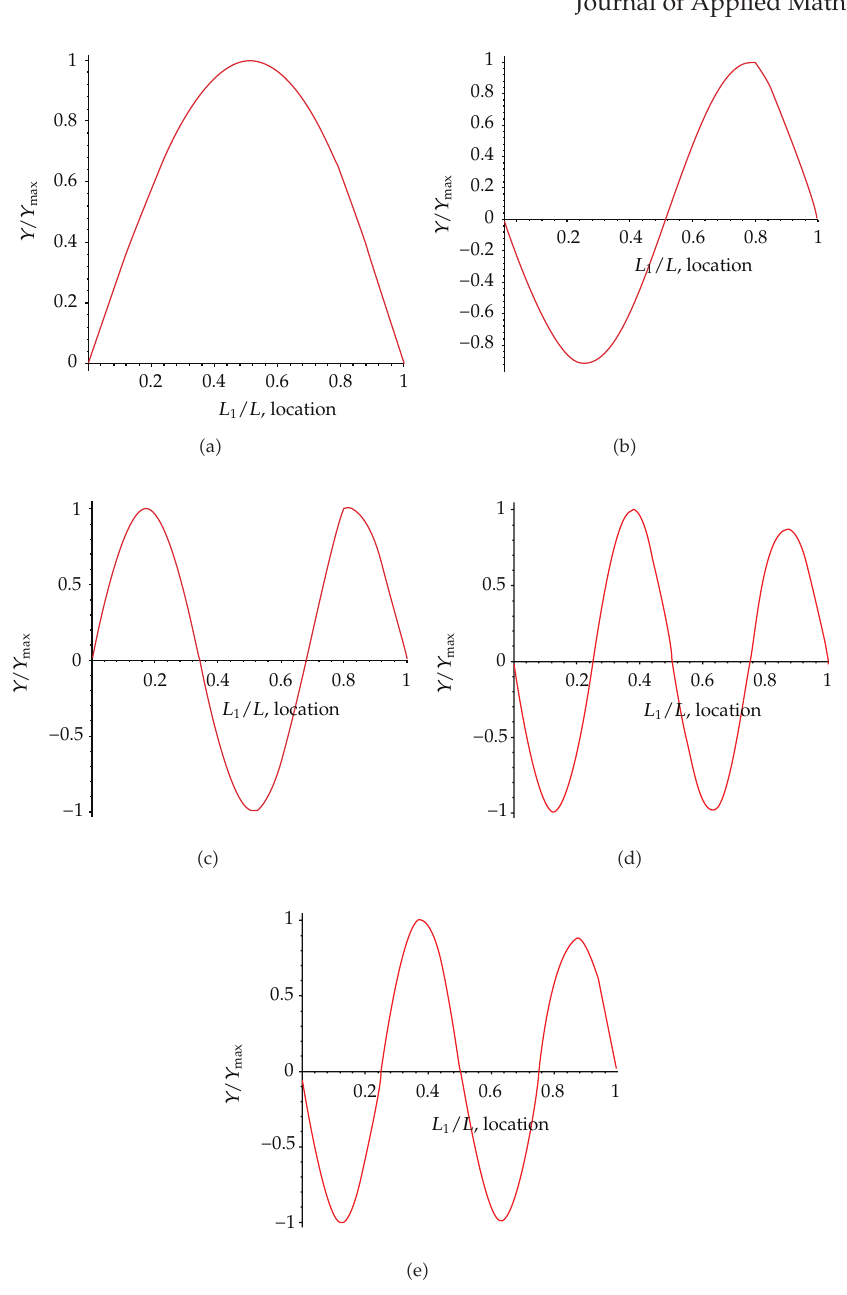
Figure 8: (cid:6) a (cid:7) Normalized mode shape of the first mode with a crack location L 1 /L (cid:5) 0 . 8 and crack depth ratio a/h (cid:5) 0 . 4. (cid:6) b (cid:7) Normalized mode shape of the second mode with a crack location L 1 /L (cid:5) 0 . 8 and crack depth ratio a/h (cid:5) 0 . 4. (cid:6) c (cid:7) Normalized mode shape of the third mode with a crack location L 1 /L (cid:5) 0 . 8 and crack depth ratio a/h (cid:5) 0.4. (cid:6) d (cid:7) Normalized mode shape of the fourth mode with a crack location /L (cid:5) 0 . 8 and crack depth ratio a/h (cid:5) 0 . 4. (cid:6) e (cid:7) Normalized mode shape of the fifth mode with a crack location L 1 /L (cid:5) 0 . 8 and crack depth ratio a/h (cid:5) 0 .